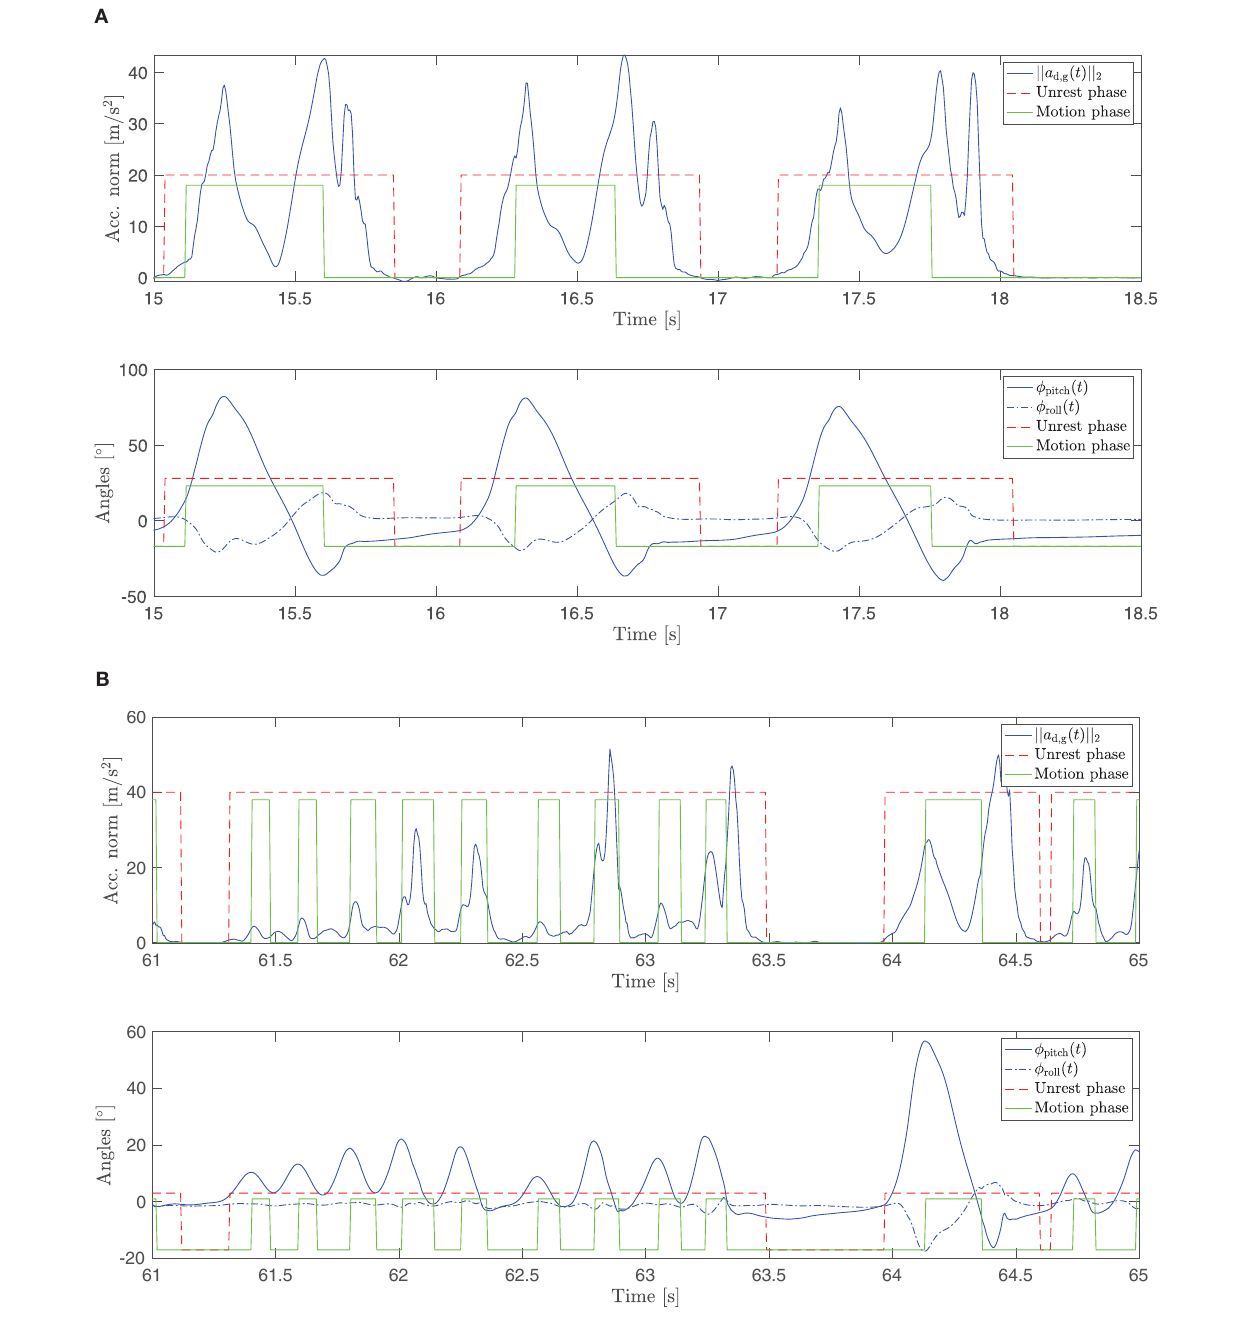
FIGURE 3 | Examples of normal (A) and pathological (B) gait cycles and the corresponding acceleration norm, roll, and pitch angles. In (B) , a shank trembling episode during turning is displayed. During this episode, no rest phases are detected between motion phases. Furthermore, the changes in the pitch angle are smaller and more frequent than during normal